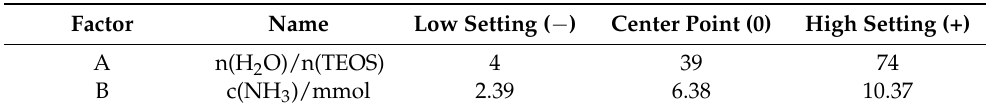
Table 4. Range of process factor-level settings as used in the face-centered-central composite experi- mental design